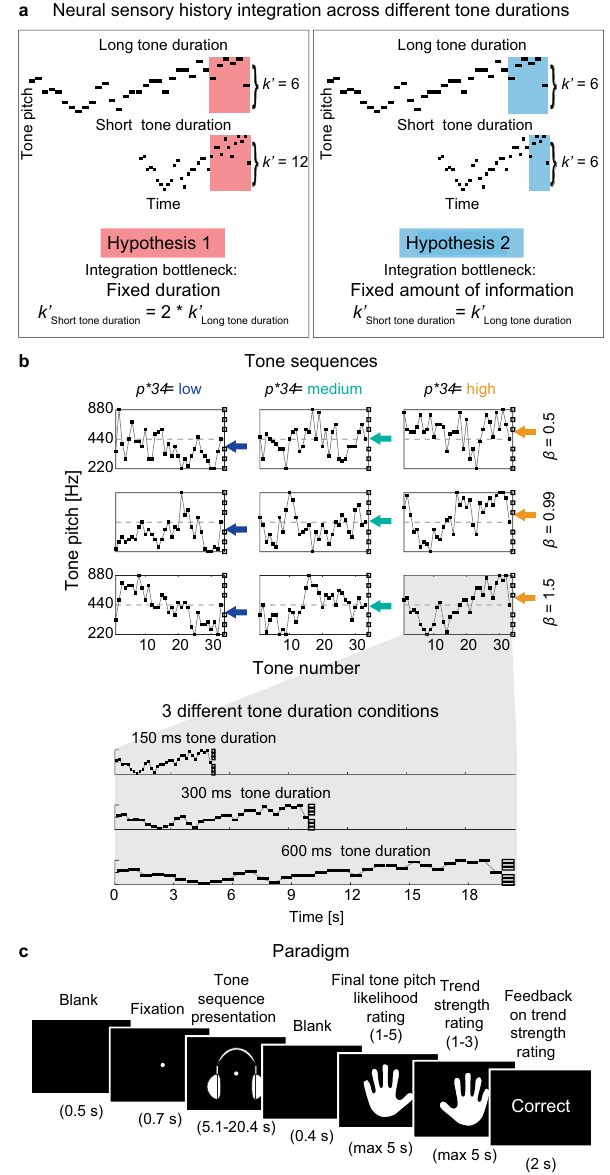
Fig. 1 Hypotheses, stimuli, and paradigm. a Hypotheses. Neural sensory history integration (SHI) can be limited by a fi xed duration (Hypothesis 1, highlighted red, temporal bottleneck) or a fi xed amount of information (Hypothesis 2, highlighted blue, informational bottleneck), resulting in a different number of neurally integrated tones ( k 0 ) across-tone duration conditions. b Full stimulus set. Tone sequences consisted of 34 tones [black squares] ordered by temporal dependence level ( β , rows) and theoretically predicted fi nal tone ( p (cid:2) [color-coded arrows], columns). For each beta 34 level, we generated three sequences with tone pitch between 220 and 880 Hz. Sequences were chosen to have a p (cid:2) lower than 440 Hz (column 1, 34 blue arrows), equal to 440 Hz (column 2, turquoise arrows), or higher than 440 Hz (column 3, yellow arrows). For all sequences, the penultimate tone ( p 33 ) was 440 Hz. The fi nal presented tone ( p 34 [empty black squares]) was pseudo-randomly drawn from one of six possible tone pitch values at 4, 8, or 12 semitones above or below 440 Hz. Sequences were presented with different tone durations (150 ms, 300 ms, 600 ms per tone). c Trial structure. After stimulus presentation, subjects rated the fi nal tone pitch likelihood given the previous sequence information on a scale of 1 –